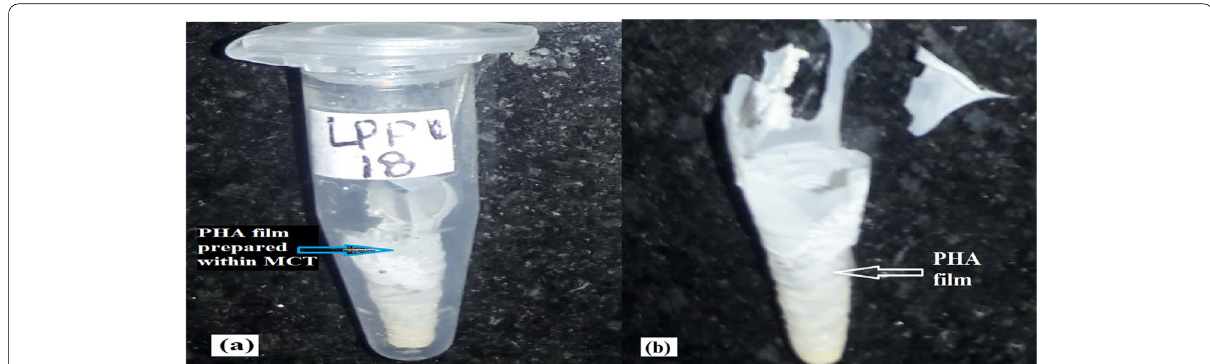
Fig. 8 a PHA film for Bacillus sp. LPPI-18 after treated with SDS-NaClO solution and dissolved within chloroform using microcentrifuge (MCT) as molding material. b A partly fractured PHA film after it had dried and was removed from